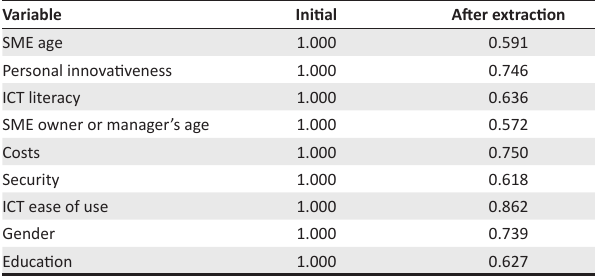
TABLE 6: Communalities.